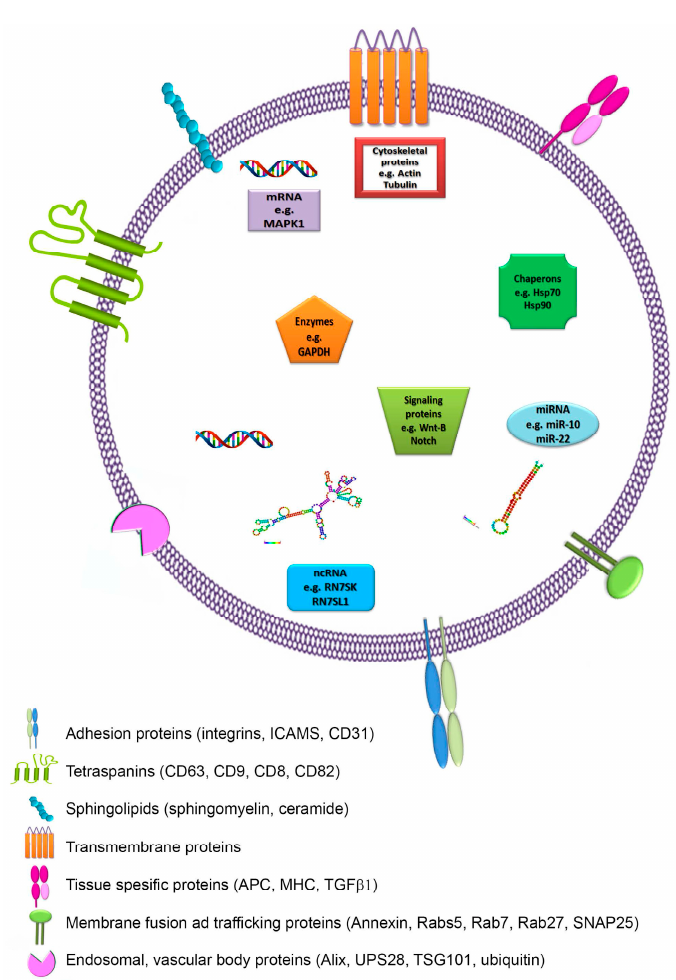
Figure 2. Molecular composition of exosomes. Exosomes are membrane-derived nanovesicles (30–100 nm in diameter) secreted from several cell types. They pack a variety of cellular components, including nucleic acids (e.g., DNA, mRNA, and miRNA), lipids (e.g., cholesterol and ceramide), mRNAs, membrane trafficking proteins (e.g., annexin, Rab 27, SNAP25), chaperones (e.g., Hsp70 and Hsp90), and various tissue-specific proteins involved in antigen presentation as integrins and tetraspanins (CD9, CD63, CD81, and CD82) as well as MHC-I and –II (Major Histocompatibility Complex).